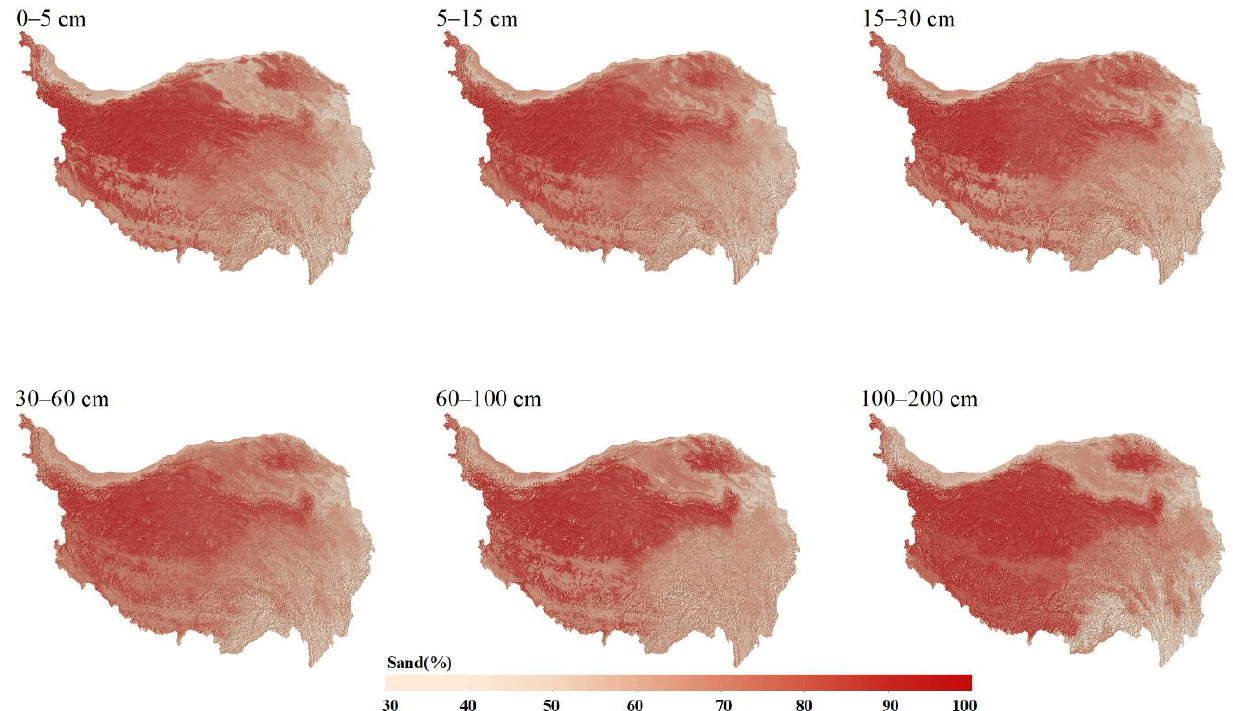
Figure 4. Spatial distribution of sand content at the six depth intervals.